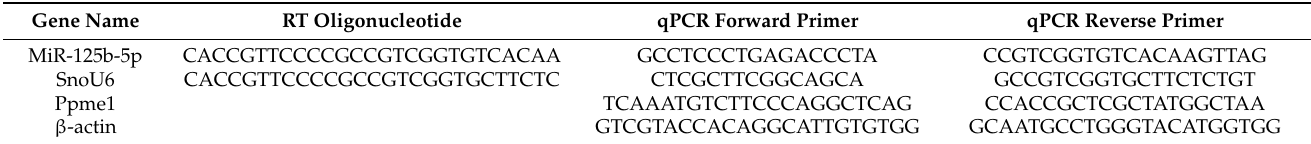
Table 1. List of RT-qPCR oligonucleotides used and assay